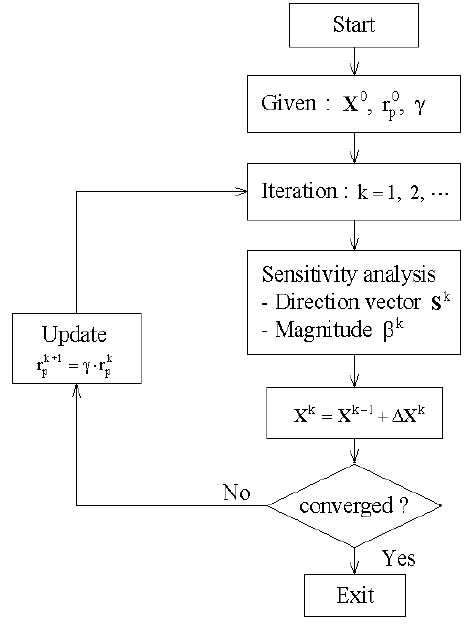
Figure 3. Flowchart of the CNT distribution optimization.